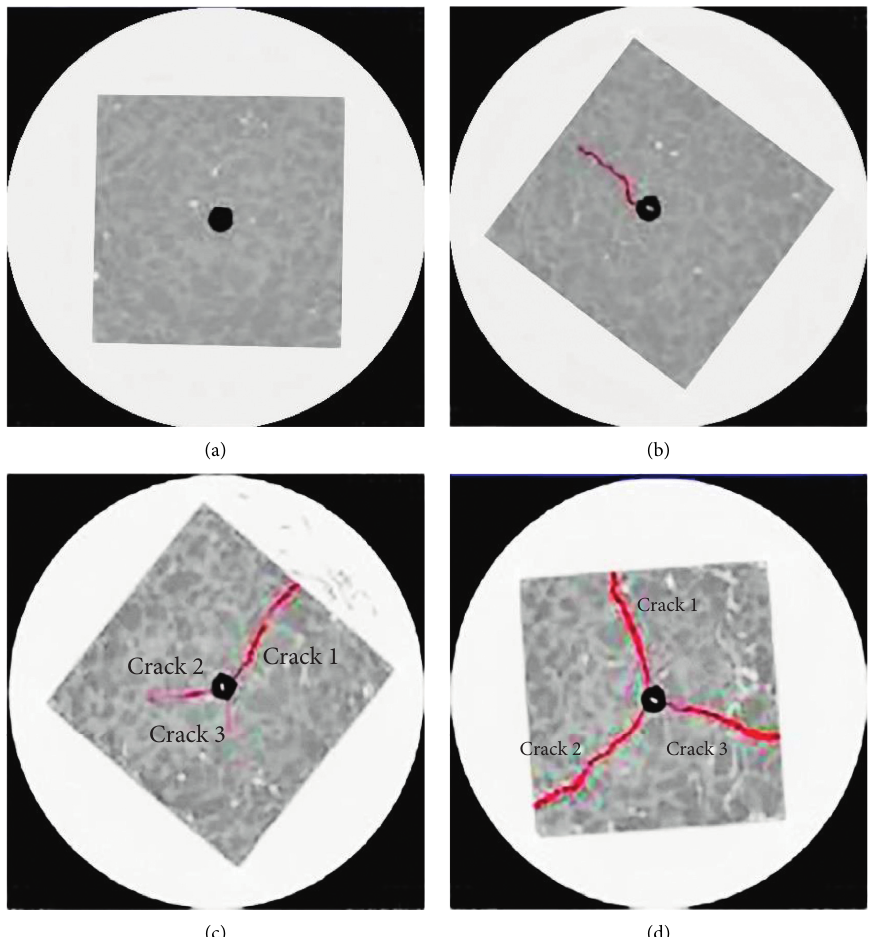
Figure 6: Specimen detecting test. (a) Corrosion rate η � 2.6%. (b) Corrosion rate η � 3.2%. (c) Corrosion rate η � 3.6%. (d) Corrosion rate η � 4.5%.